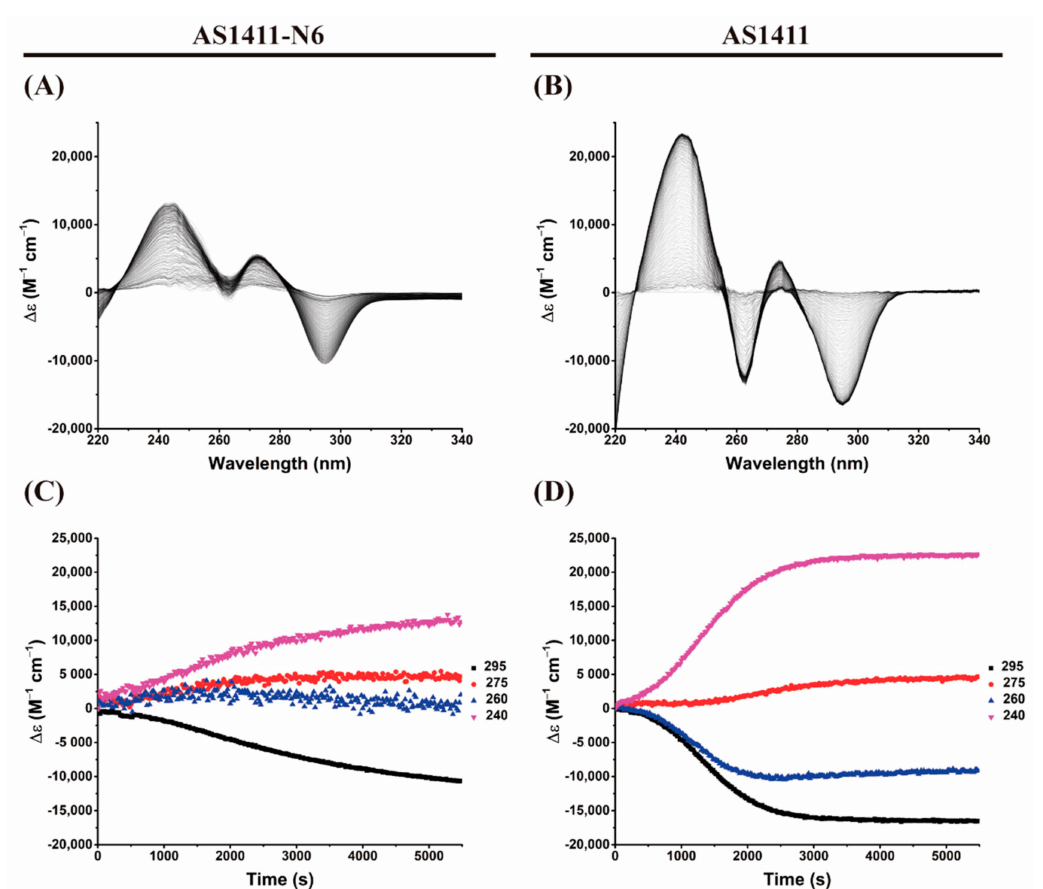
Figure 6. IDS time-dependent spectra for ( A ) AS1411-N6 and ( B ) AS1411 after the addition of 20 mM KCl. The bottom panel represents the time-evolution of the absorbance at selected wavelengths to allow the calculation of kinetic parameters. The kinetic plots ( C , D ) correspond to AS1411-N6 and AS1411,